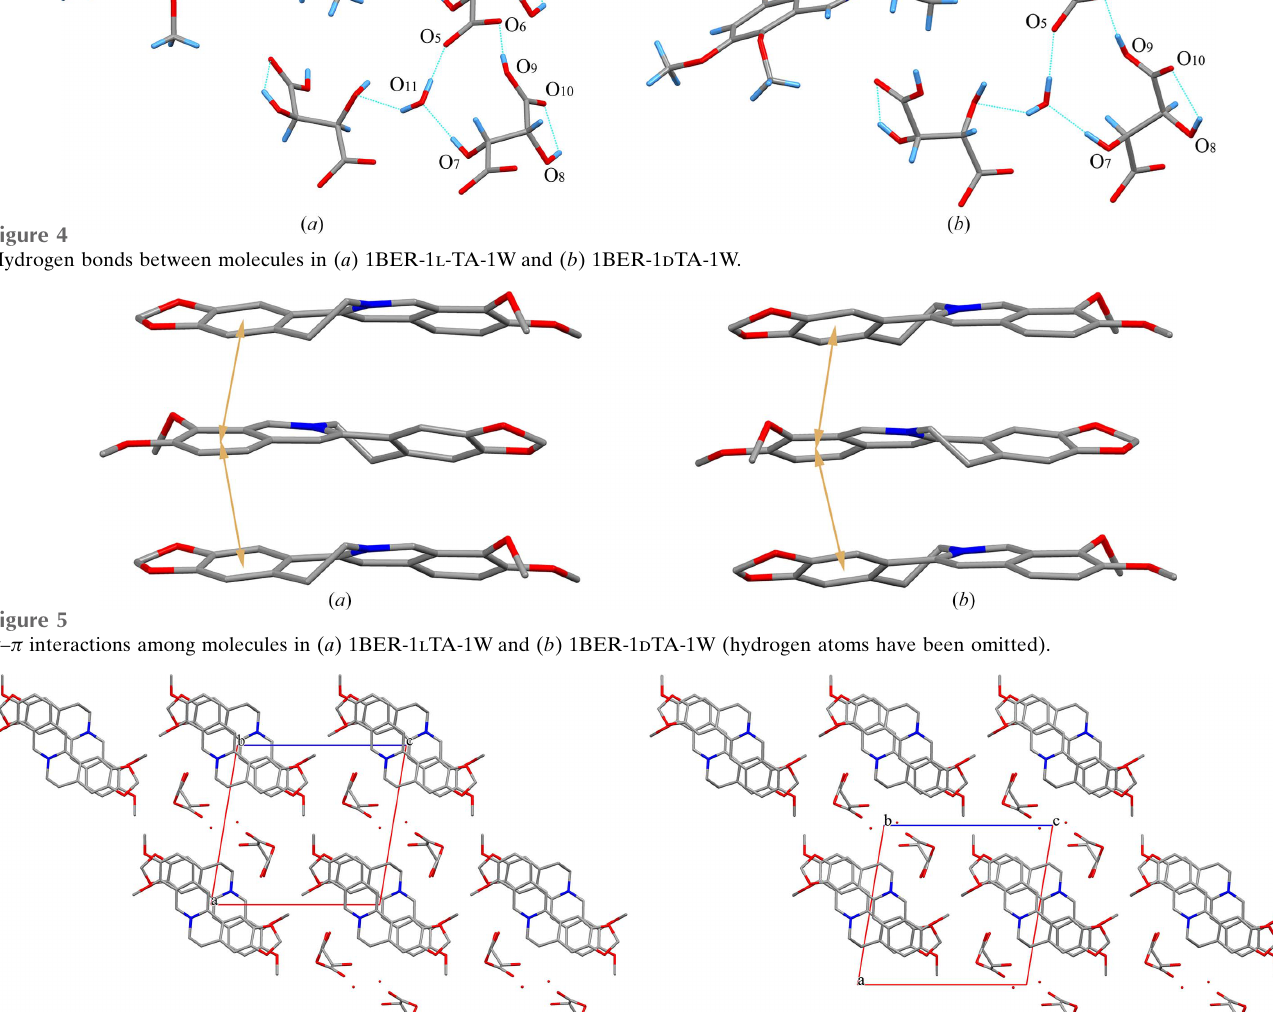
Figure 6 Three-dimensional structures of ( a ) 1BER-1 l -TA-1W and ( b ) 1BER-1 d TA-1W (hydrogen atoms have been molecular hydrogen bond O